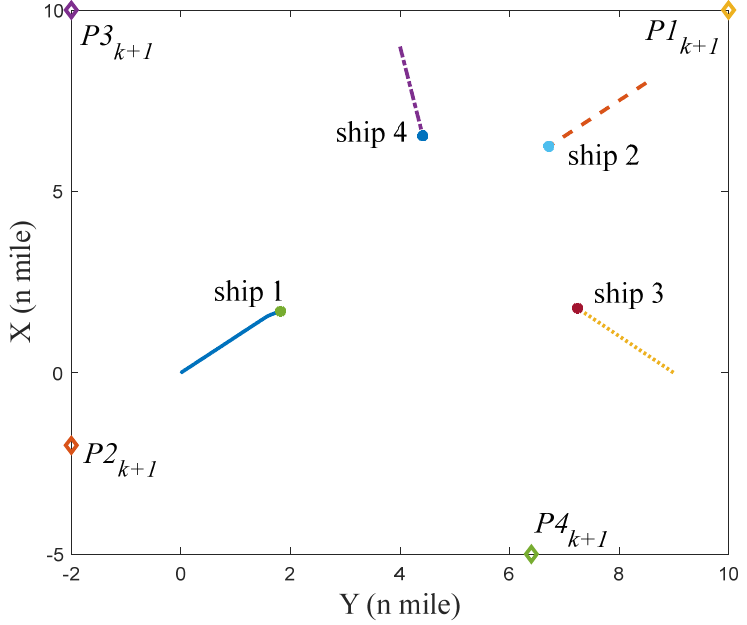
Figure 25. The situation of four ships at t = 600 s in scenario 3 under environment disturbance.